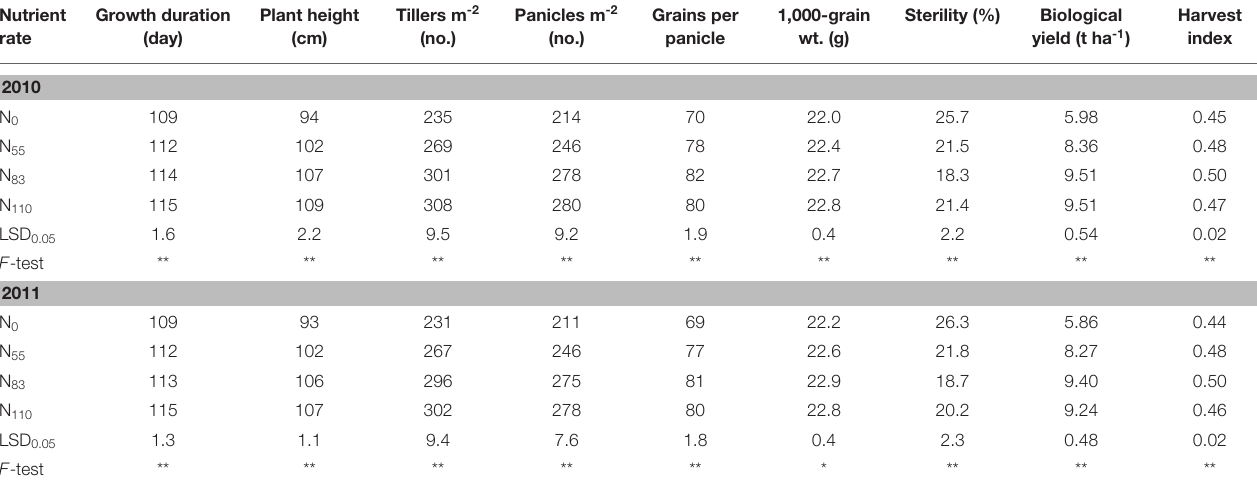
TABLE 3 | Effect of N rates on growth duration, yield components, and agronomic attributes (averaged across all genotypes). Nutrient Growth duration rate (day)